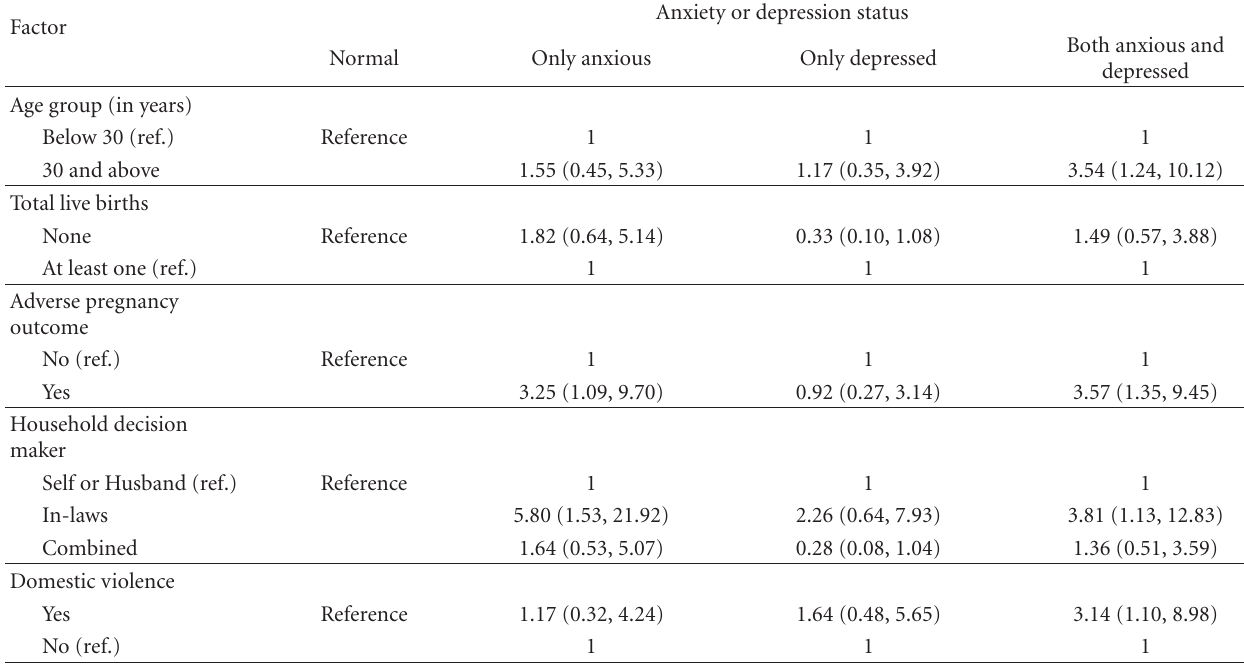
Table 3: Adjusted odds ratio (95% CI) by sociodemographic, obstetric, family relationships, and home environment characteristics. Anxiety or depression status Factor Both anxious and Normal Only anxious Only depressed